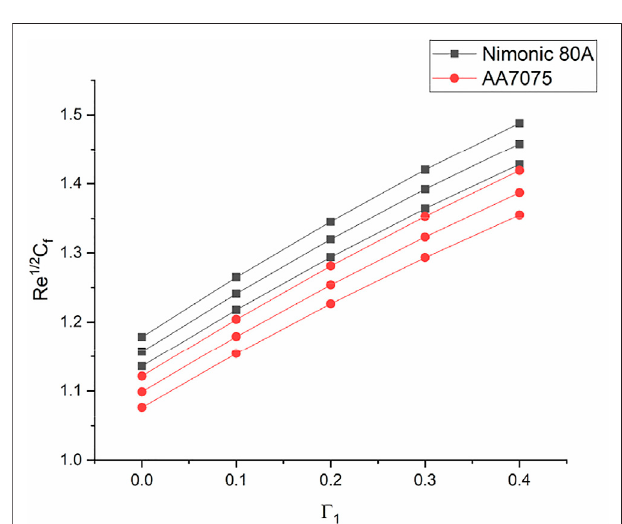
FIGURE 6 | Provocation of Sc on χ 1 .